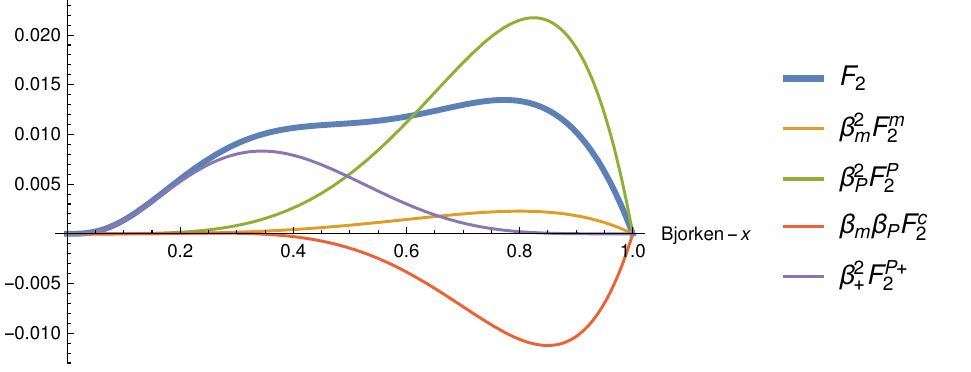
Figure 4 . The full structure function F 2 (blue line) as a function of the Bjorken parameter x , obtained from the contribution of the twist-3 spin-1/2 fermionic operator the curves is analogous as describe in figure